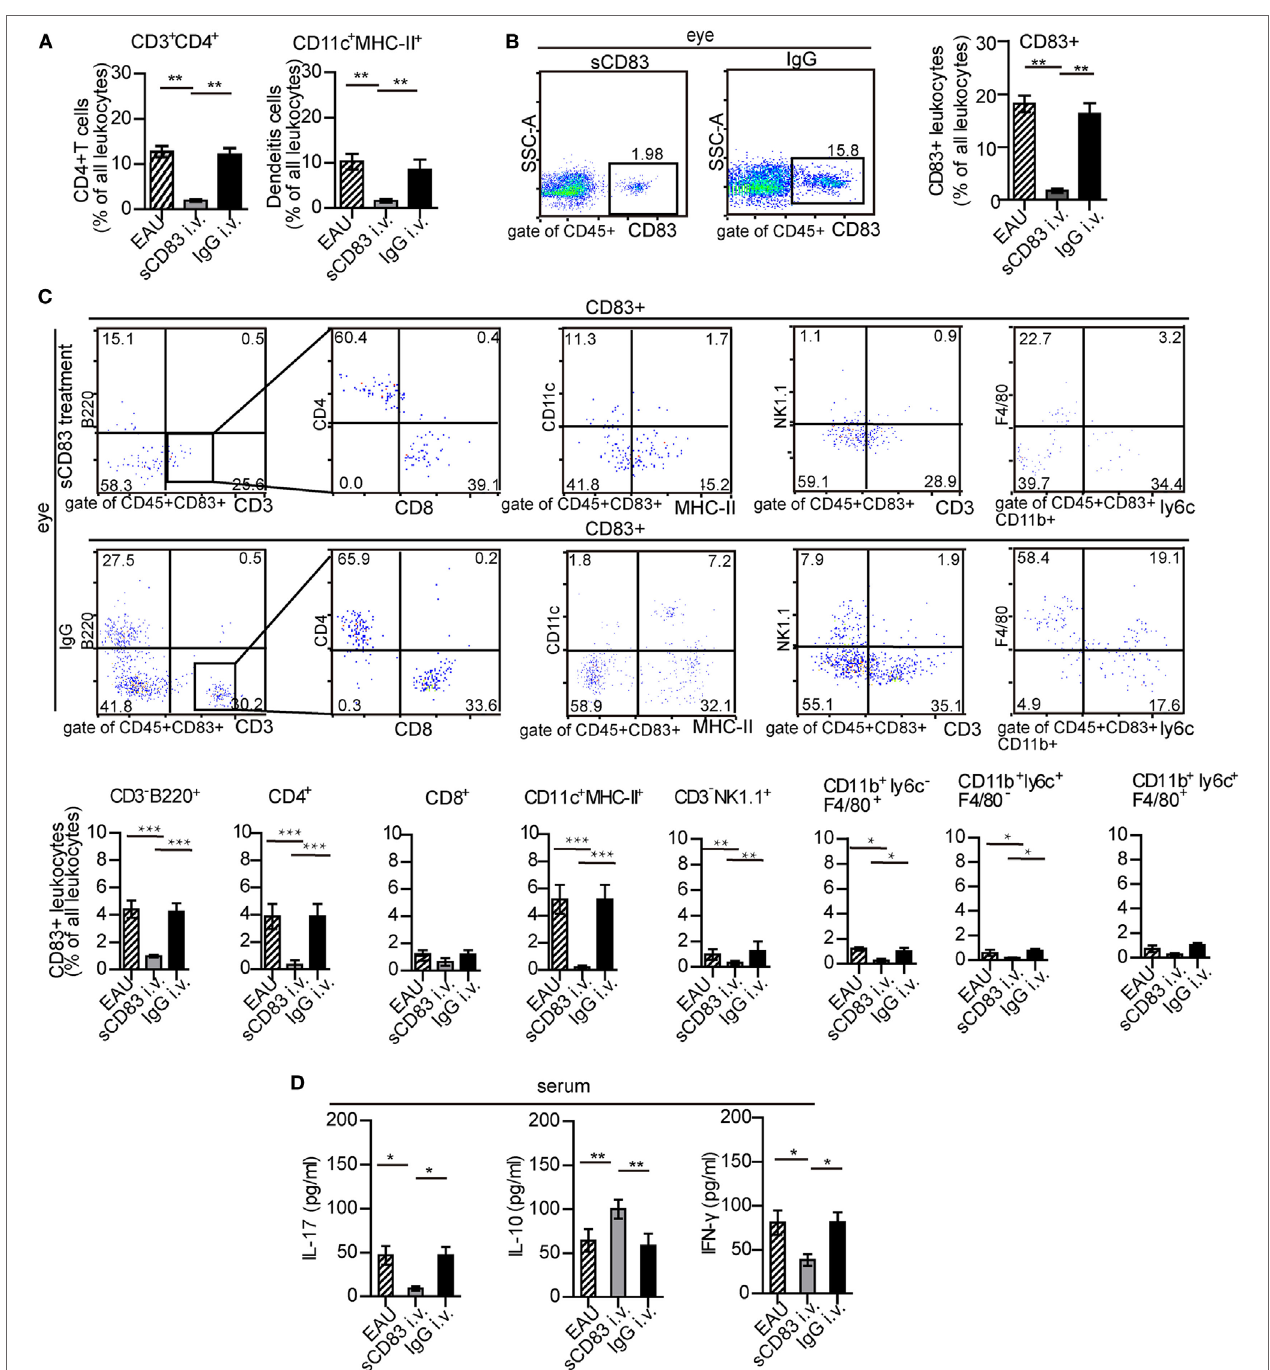
FigUre 3 | Soluble CD83 (sCD83) impedes ocular leukocyte infiltration in experimental autoimmune uveitis (EAU). (a,B) Flow cytometry analysis of ocular CD3 + CD4 + T cells, CD11c + MHC-II + dendritic cells (DCs), and CD83 + leukocytes from i.v. sCD83-treated mice and IgG 1 -treated mice. Gating strategy is shown in Figure S1 in Supplementary Material. (c) Ocular CD83 + leukocytes subsets were assessed by flow cytometry. (D) Serum concentrations of IL-17, IFN- γ , and IL-10 were determined by ELISA. All data are shown as mean ± SEM, n = 3 in triplicates, one-way ANOVA LSD- t test. *** p < 0.001, ** p < 0.01, * p <